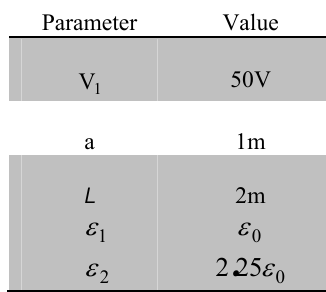
Table 3: Parameters for Case II.